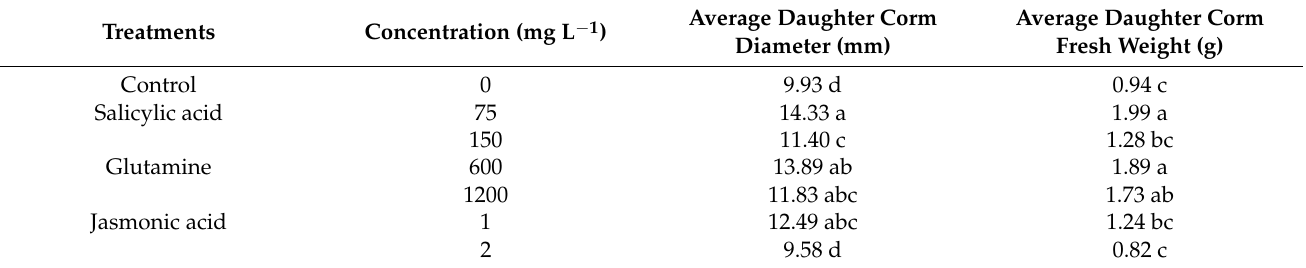
Table 2. Effects of salicylic acid, glutamine, and jasmonic acid treatments on saffron daughter corm diameter and fresh weight after 14 weeks of culture.